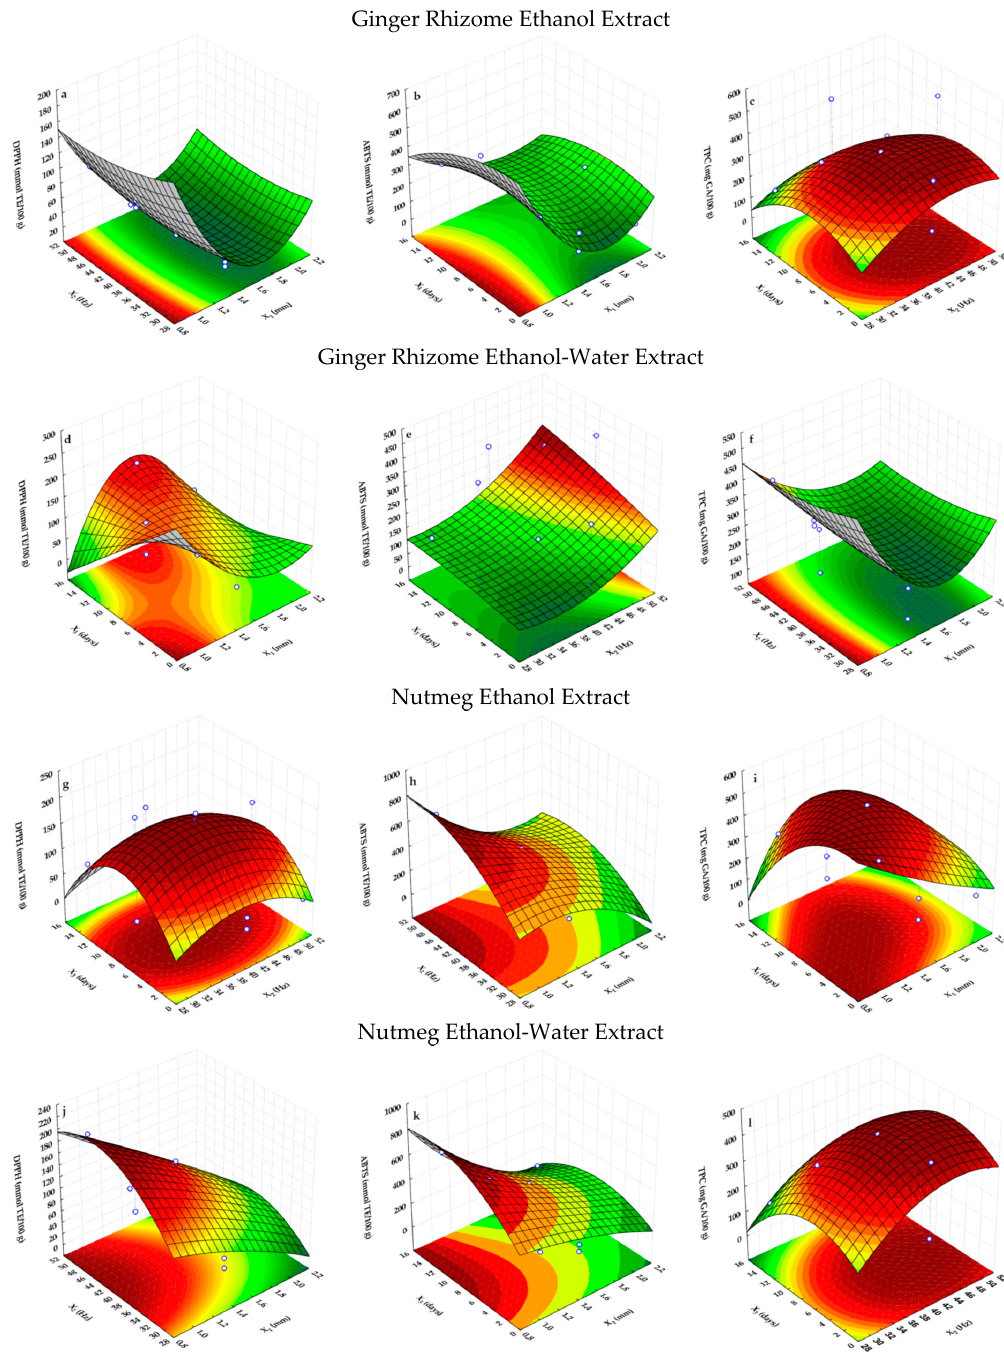
Figure 1. Response surfaces and contour plots showing the interactive influence of the mesh size of the grinder sieve (X 1 ), the peripheral velocity of grinding wheels (X 2 ) and the storage time of the ground spices (X 3 ) on their antioxidant capacity determined by the DPPH ( a , d , g , j ), ABTS ( b , e , h , k ), and F–C ( c , f , i , l )